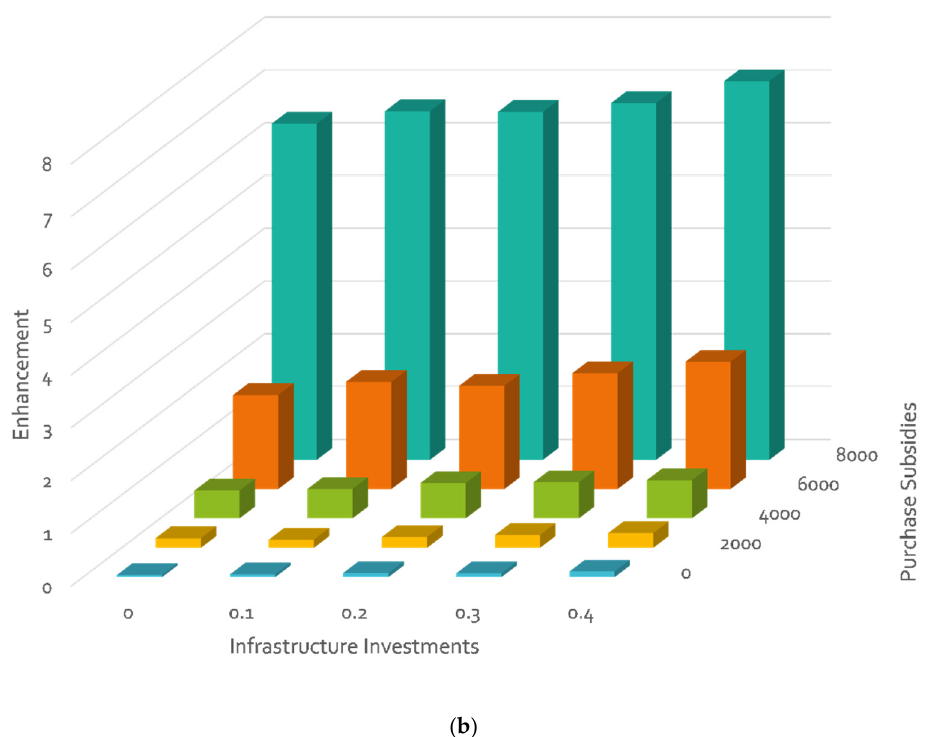
Figure 9. Results for different incentive constellations in 2030: ( a ) no rise in fuel prices; ( b ) rise in fuel-price of 20 cents.